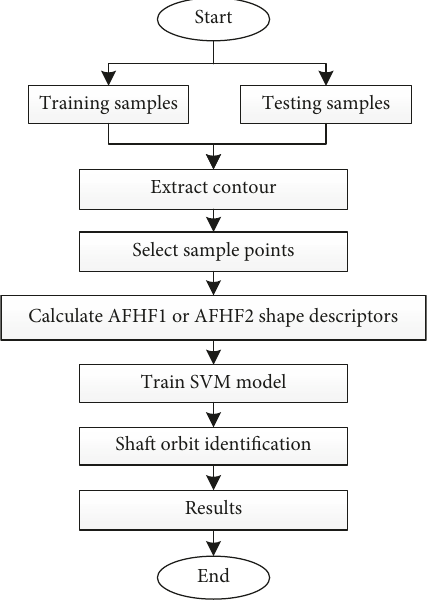
Figure 4: Process of shaft orbit identification method based on AFHFs and SVM. Table 2: Shaft orbit shapes of different